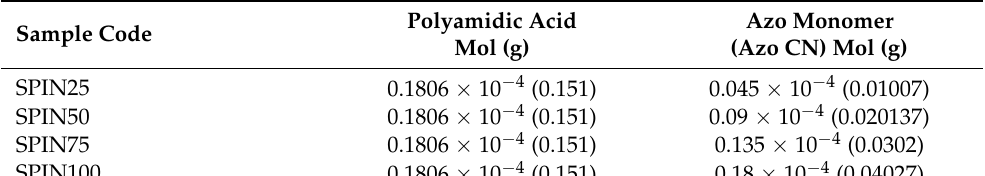
Table 1. Quantities of polyamidic acid and azo monomer used in the PI-based supramolecular systems.